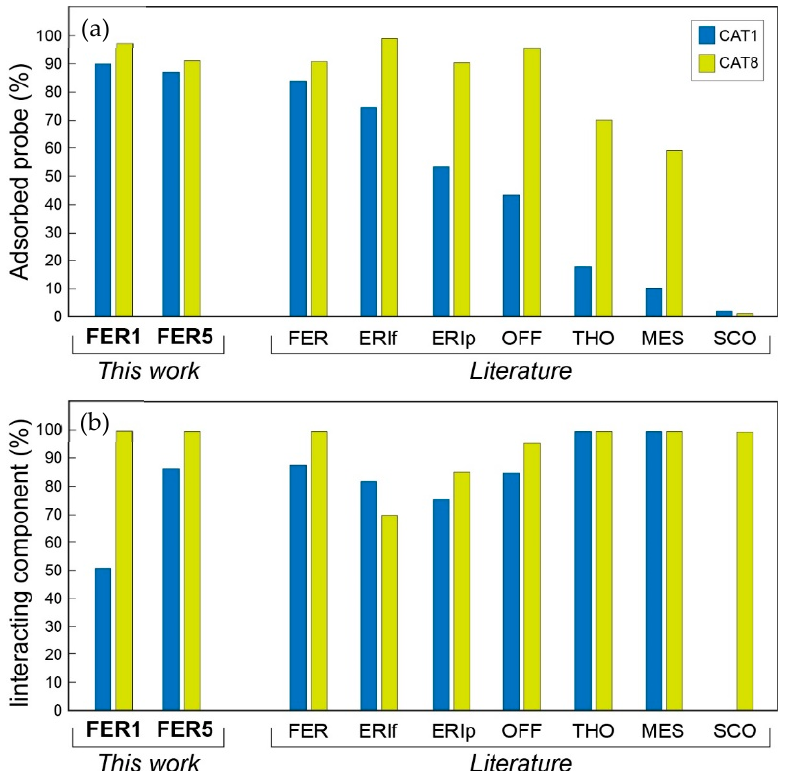
Figure 8. Comparison of the adsorbed percentage of probes ( a ) and interacting component ( b ) of the studied ferrierite samples (FER1 and FER5) with that of other fibrous zeolites. FER = ferrierite samples (BC, LN); data from Gualtieri et al. [20]. ERIf = fibrous erionite (GF1), ERIp = prismatic erionite (MD8), OFF = offretite (BV12), SC1 = scolecite; data from Mattioli et al. [11]. THO = thomsonite (GF3b), MES = mesolite (GF3a); data from Giordani et al. [14].